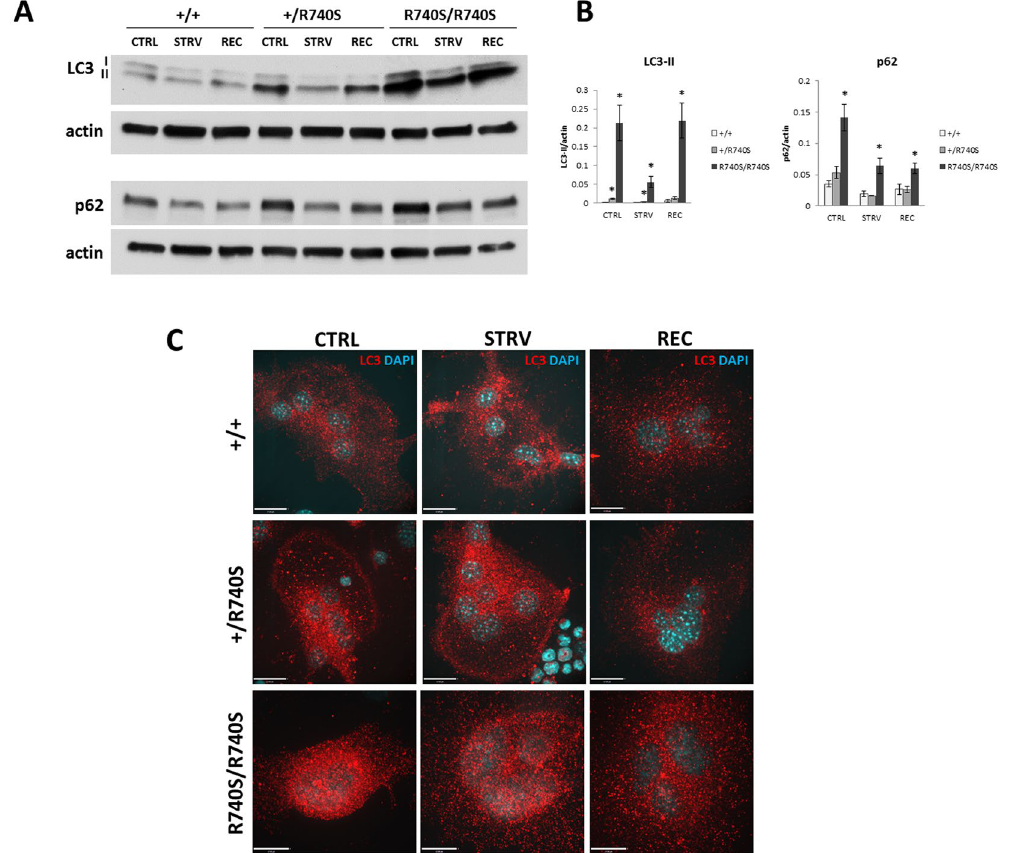
Figure 2. Autophagy is inhibited in osteoclasts with R740S mutation. Spleen-derived osteoclasts were differentiated as described in “Materials and Methods”. ( A ) Immunoblotting, representative cropped blots of 4 independent experiments. On day 4 of culture, the cells were incubated with HBSS (starvation) for 60 min, and then in fully supplemented media for additional 30 min. Whole cell lysates were separated on 4–20% gradient gels, transferred to a nitrocellulose membrane and probed for LC3, p62 and actin. ( B ) Quantification of immunoblots; combined normalized data of 4 independent experiments, mean ± std. dev; * indicates statistical significance compared to + / + control, p < 0.05. ( C ) LC3 immunostaining. Spleen-derived osteoclasts were treated as described in ( A ), fixed, stained with anti-LC3B antibody as described in “Materials and Methods”; nuclei were stained with DAPI. Representative images. Bars, 17 μ